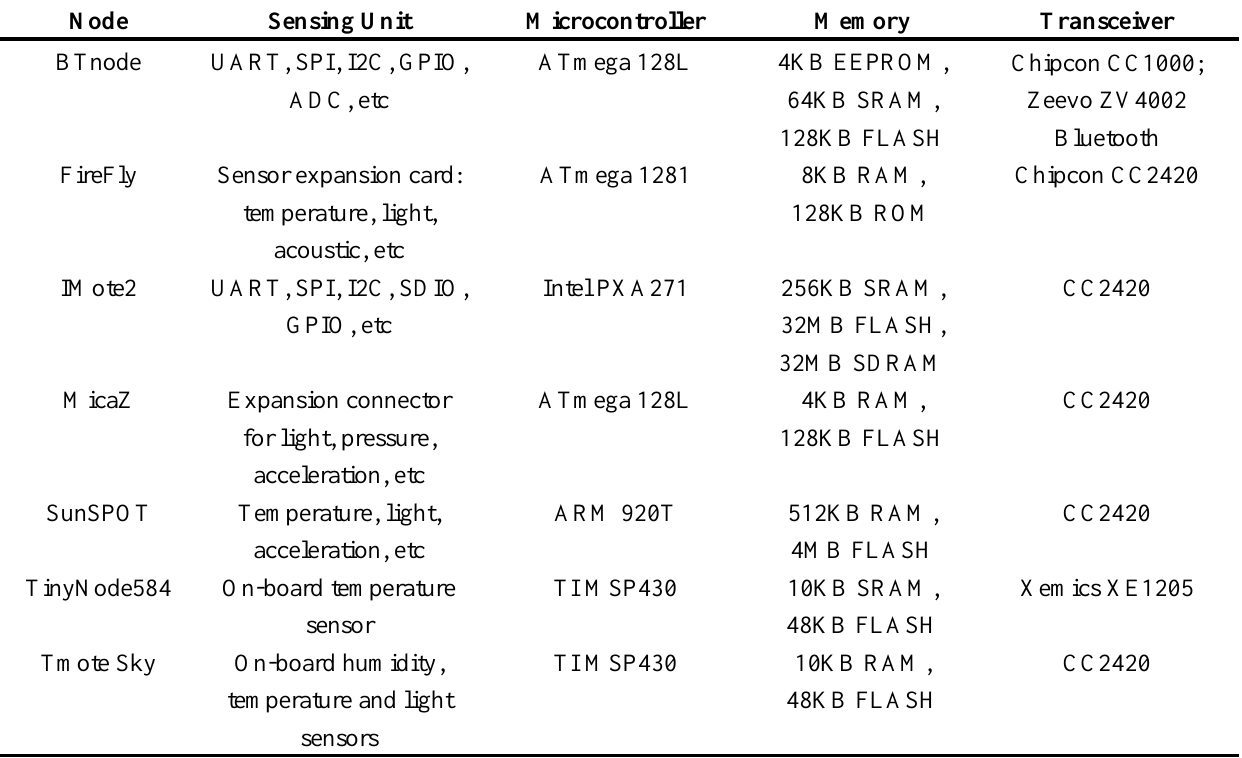
Table 1. Some available wireless sensor